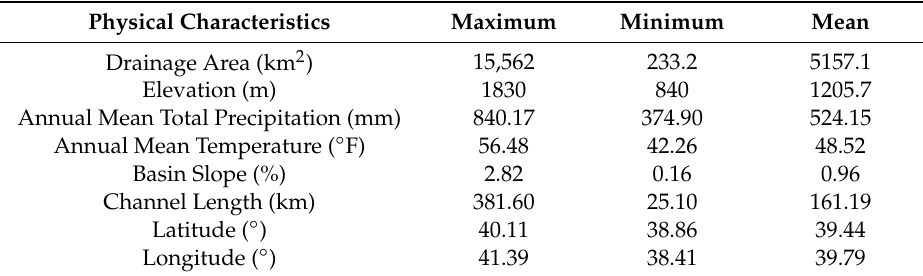
Table 4. Statistics of physical characteristics used in the Upper Euphrates Basin.